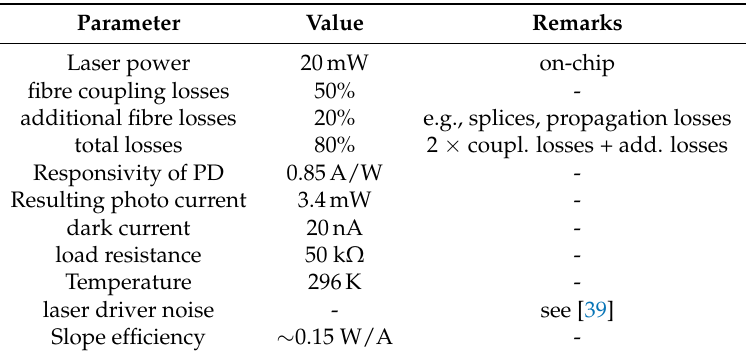
Table 1. Parameter list used in the